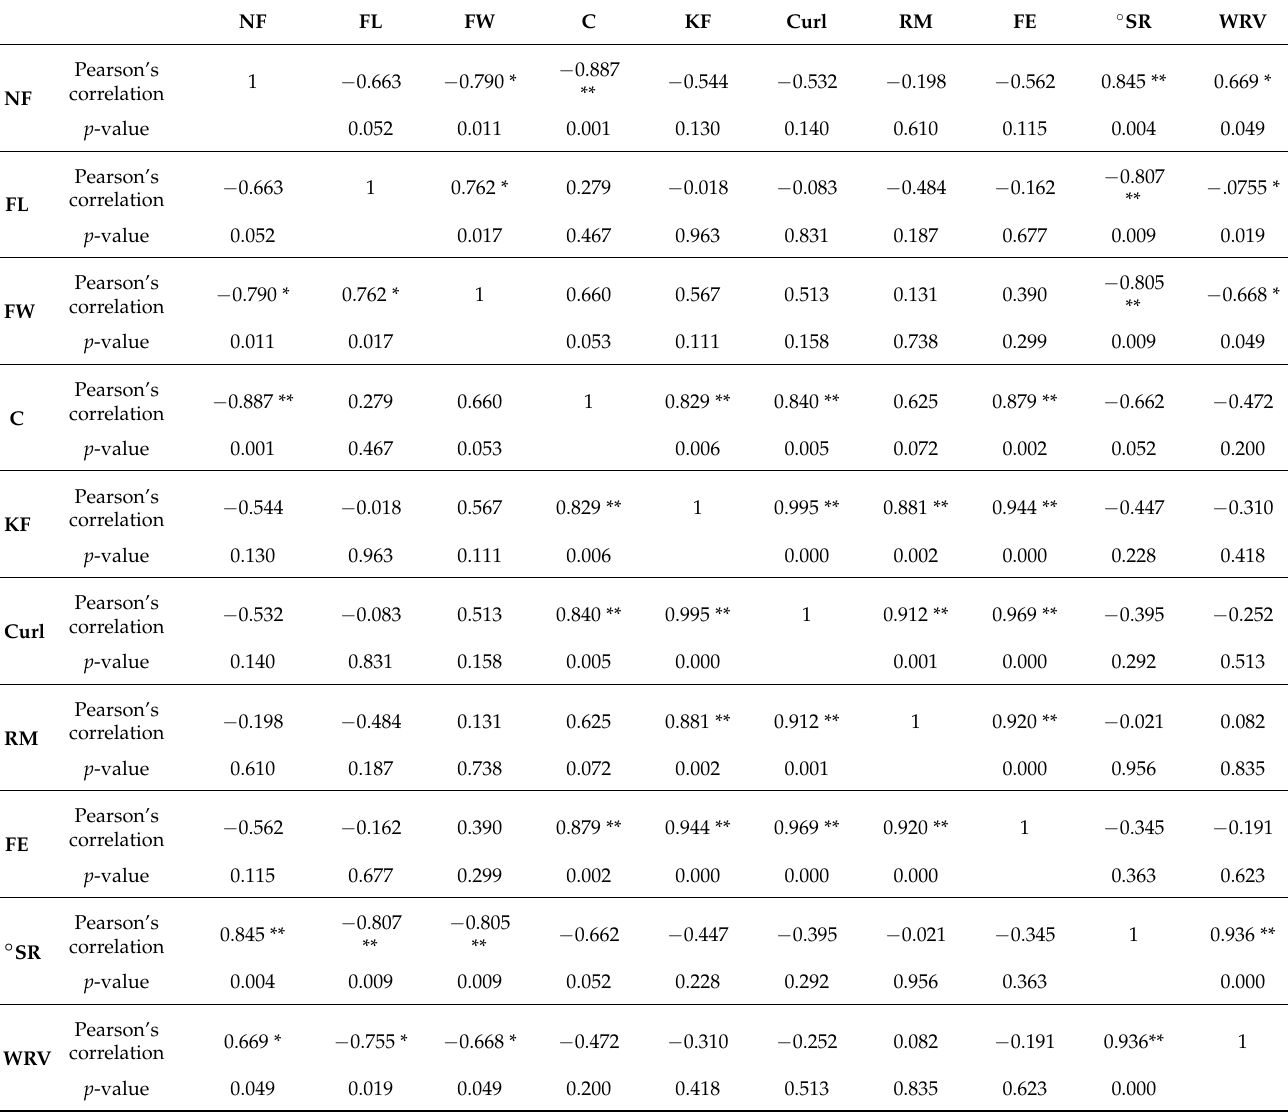
Table 5. Pearson’s correlation values for each fiber morphology and water interaction